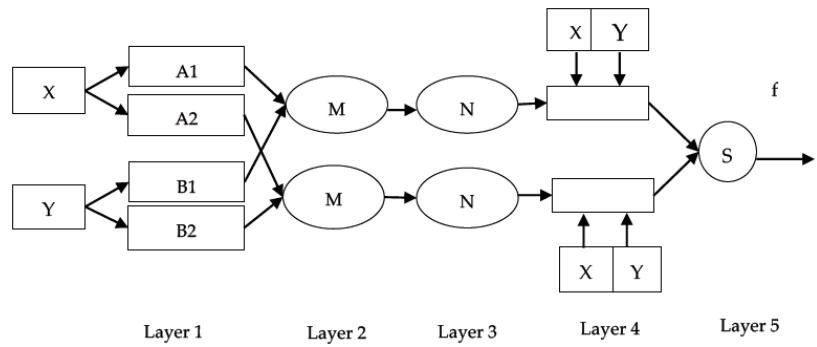
Figure 1. General framework of adaptive neuro-fuzzy inference system (ANFIS).